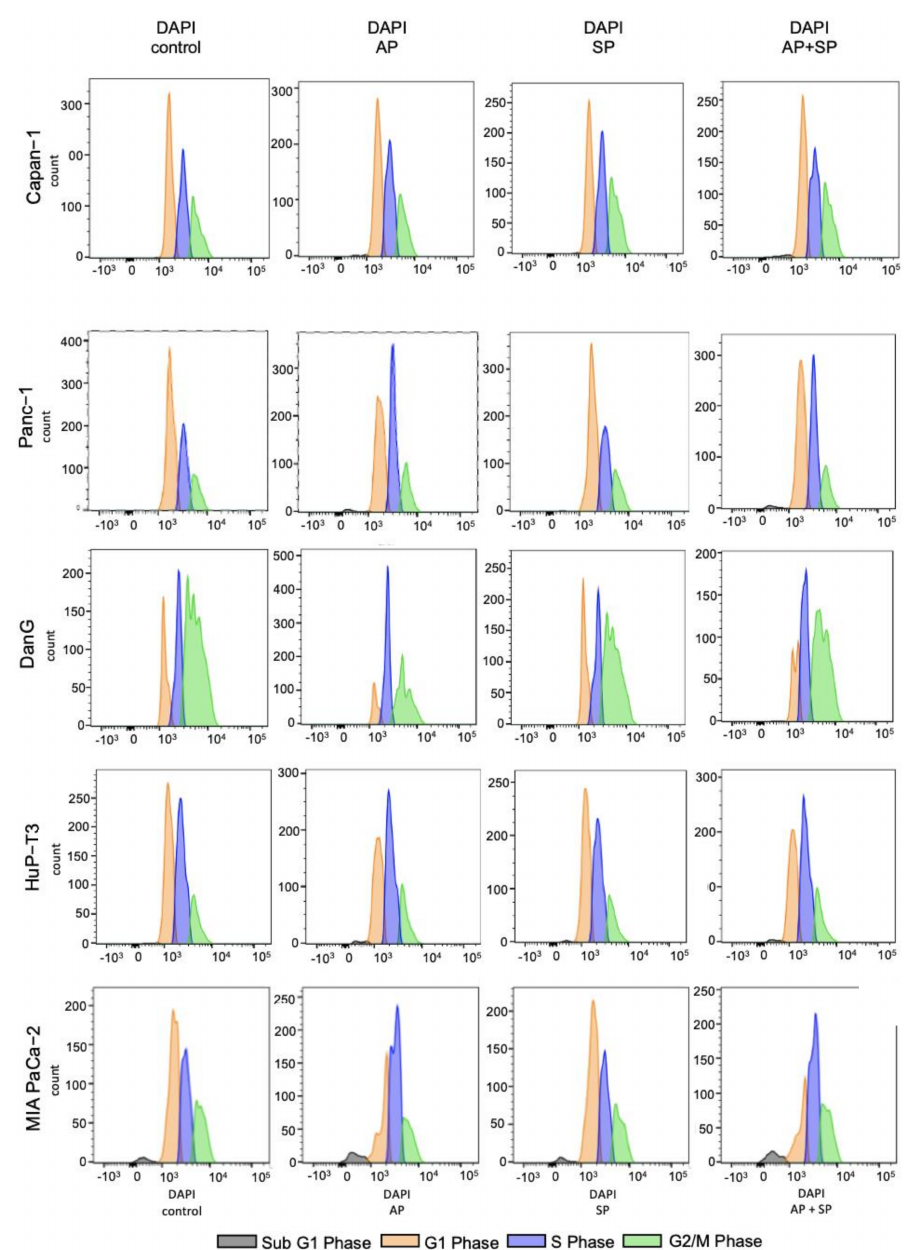
Figure A1. Histogram extension of Figure 5. Histograms showing treatment reaction to AP, SP, and AP+SP after DAPI staining in the indicated cell lines for cell cycle